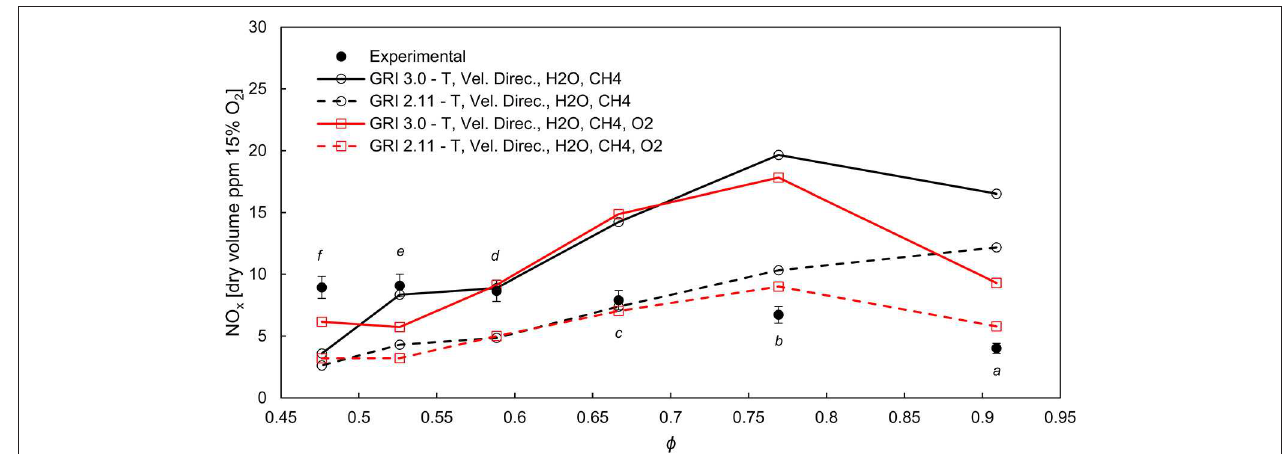
FIGURE 12 | Outlet NO x results from AGNES having CFD simulations performed with FGM as input compared with experimental results. Two different clustering criteria sets.